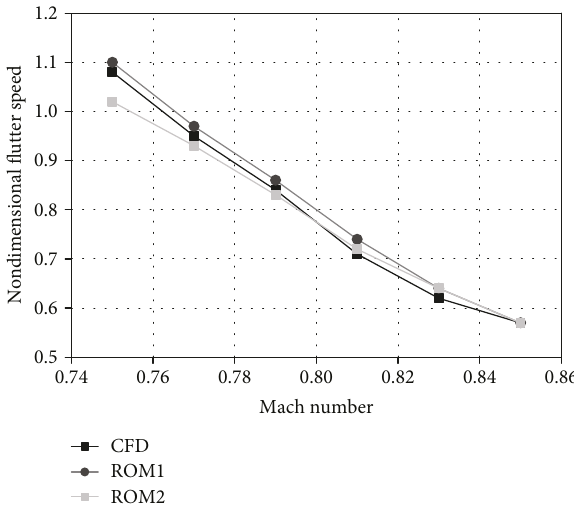
Figure 16: The fl utter boundary of the airfoil with the mean angle of attack α = 1 deg (ROM1-training data via CFD; ROM2-training 0 data via the proposed method).